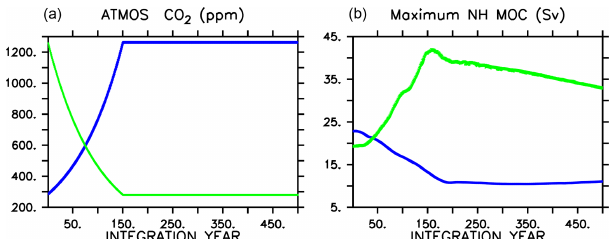
Figure 1. Atmospheric CO 2 forcing used for WARMING icehouse (blue) and COOLING greenhouse (green) experiments (a) , and maximum Northern Hemisphere meridional overturning (b) . Dot- ted lines represent the MIXED model, thin dashed lines represent the NOCACO3TR model, and thick dashed lines represent the CAL model. The physical responses of the models to WARMING and COOLING forcing are nearly